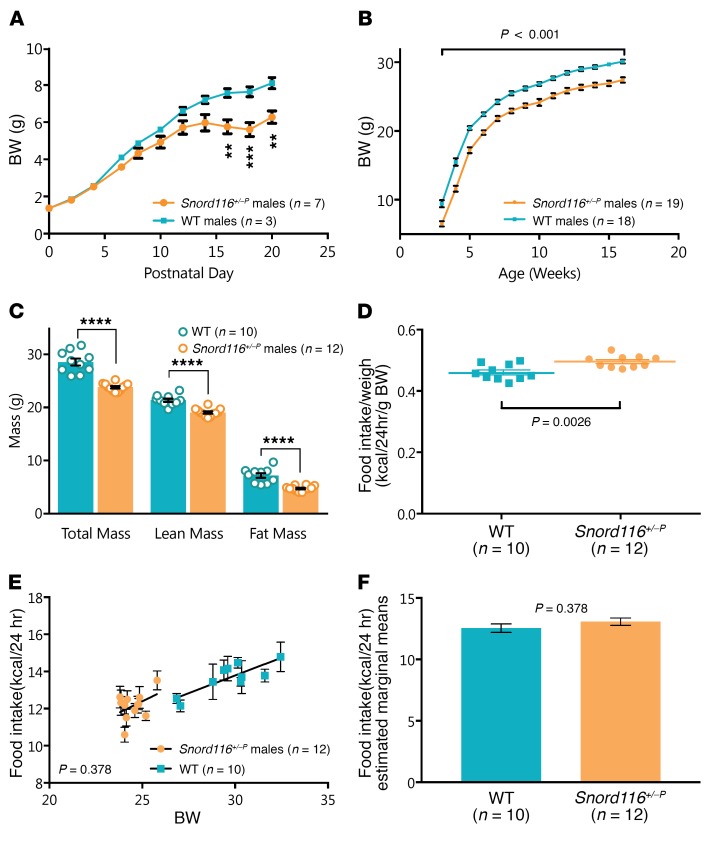
Congenital Snord116 deletion mice display a growth phenotype, but do not transition to obesity or hyperphagia.(A) Postnatal body weight is lower in Snord116+/–P (n = 7) versus WT (n = 3) mice, measured to 20 days after birth. Significant weight differences were observed from day 16. **P < 0.01; ***P < 0.001, 2-way repeated-measures ANOVA. (B) Adult body weight in Snord116+/–P (n = 19) mice remains below that of WT (n = 18) mice, measured between 3 and 16 weeks of age, with significant effect of genotype on body weight observed throughout adulthood. P < 0.001, 2-factor mixed-design ANOVA. (C) All mass subcomponents are decreased in Snord116+/–P (n = 12) versus WT (n = 10) mice, as measured in adult males 13 to 16 weeks of age. ****P < 0.0001, t test. (D–F) Analysis of daily food intake (10-day average) in Snord116+/–P (n = 12) versus WT (n = 10) mice at 13–16 weeks of age reveals that, (D) when divided by body weight, food intake is significantly higher in Snord116+/–P mice (t test, P = 0.0026); however, when food intake is (E) plotted in relation to body weight as a covariate and (F) ANCOVA-corrected for differences in body weight, there is no evidence for altered food intake between WT and Snord116+/–P mice (ANCOVA, P = 0.378). Data are reported for male mice as mean ± SEM.